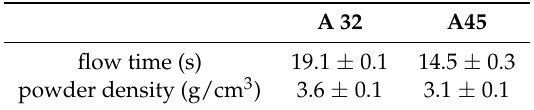
Table 2. Flowability and powder density of powder A32 and